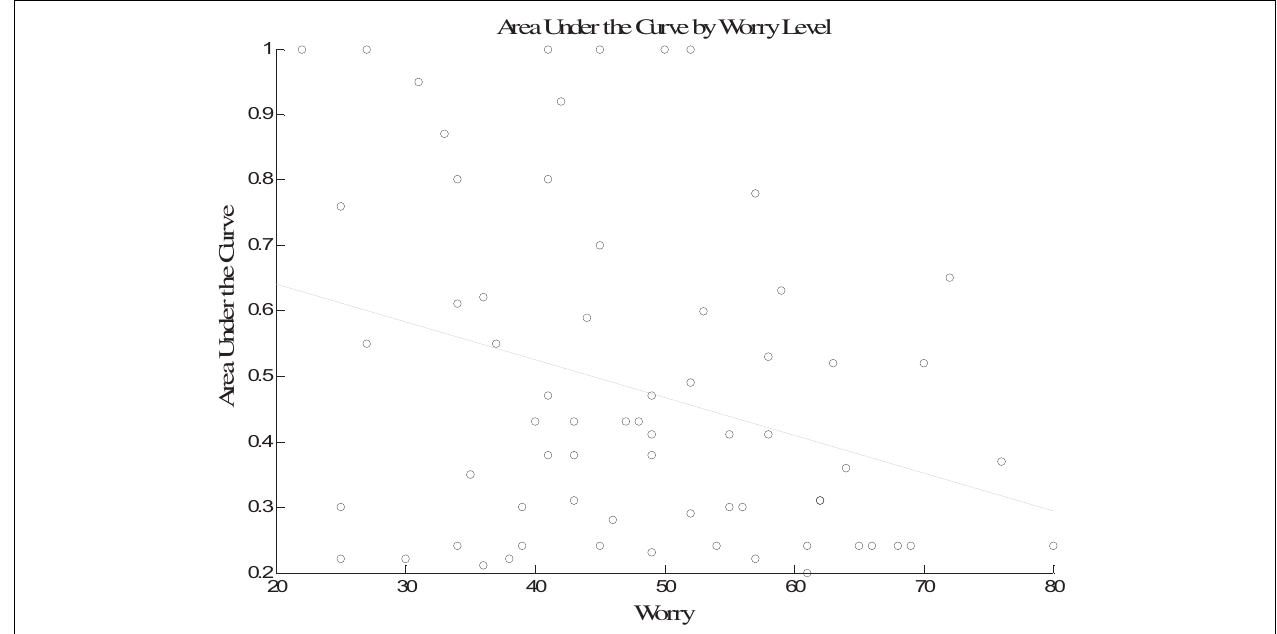
FIGURE 5 | Delay discounting score (area under the curve) plotted as a function of worry.